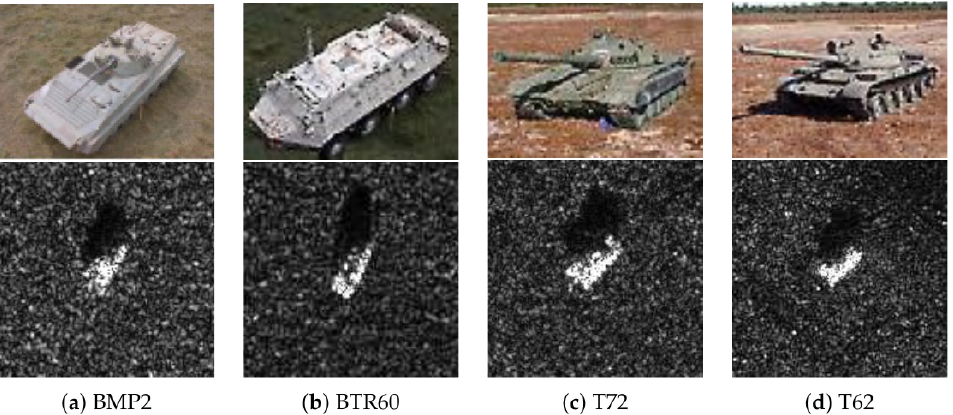
Figure 11. The top row shows the optical pictures and the bottom row exhibits the corresponding SAR image. ( a ) The optical image and the SAR image of BMP2. ( b ) The optical image and the SAR image of BTR60. ( c ) The optical image and the SAR image of T72. ( d ) The optical image and the SAR image of